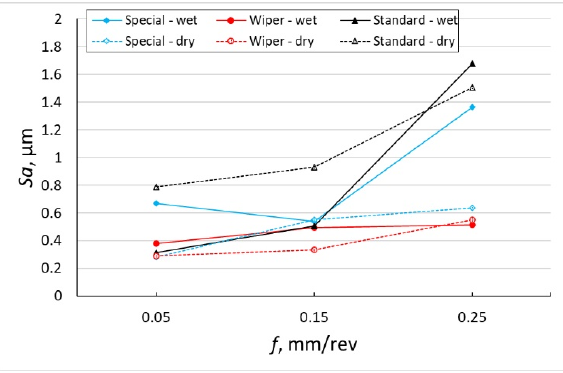
Figure 7. The impact of feed f on the variability of roughness parameter Sa .